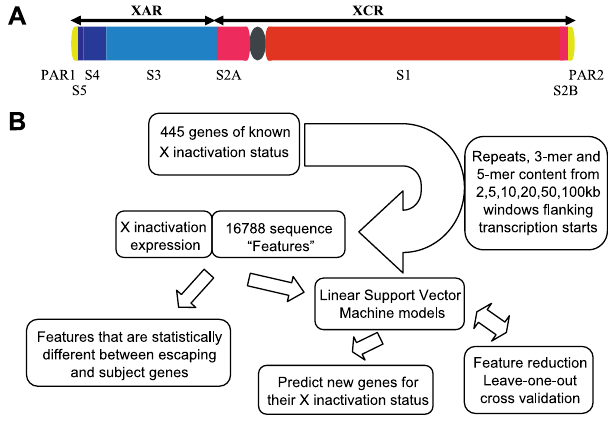
(A) A schematic drawing of the X chromosome delineating each evolutionary stratum [13,15]. (B) Strategy for statistical analysis and SVM training and classification. DOI: